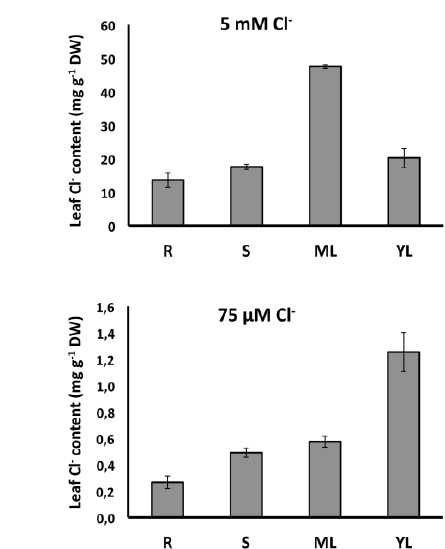
Figure 3. Preferential accumulation of Cl − in growing tissues. When available at macronutrient levels ( A ), Cl − is distributed throughout the plant, reaching its maximum concentration in adult leaves, where it is stored in their large vacuoles. When present at lower concentrations, sufficient to meet micronutrient requirements but insu ffi cient as a macronutrient ( B ), tobacco plants prioritize preferential Cl − accumulation in actively growing young leaves, indicating a biological role in plant cell